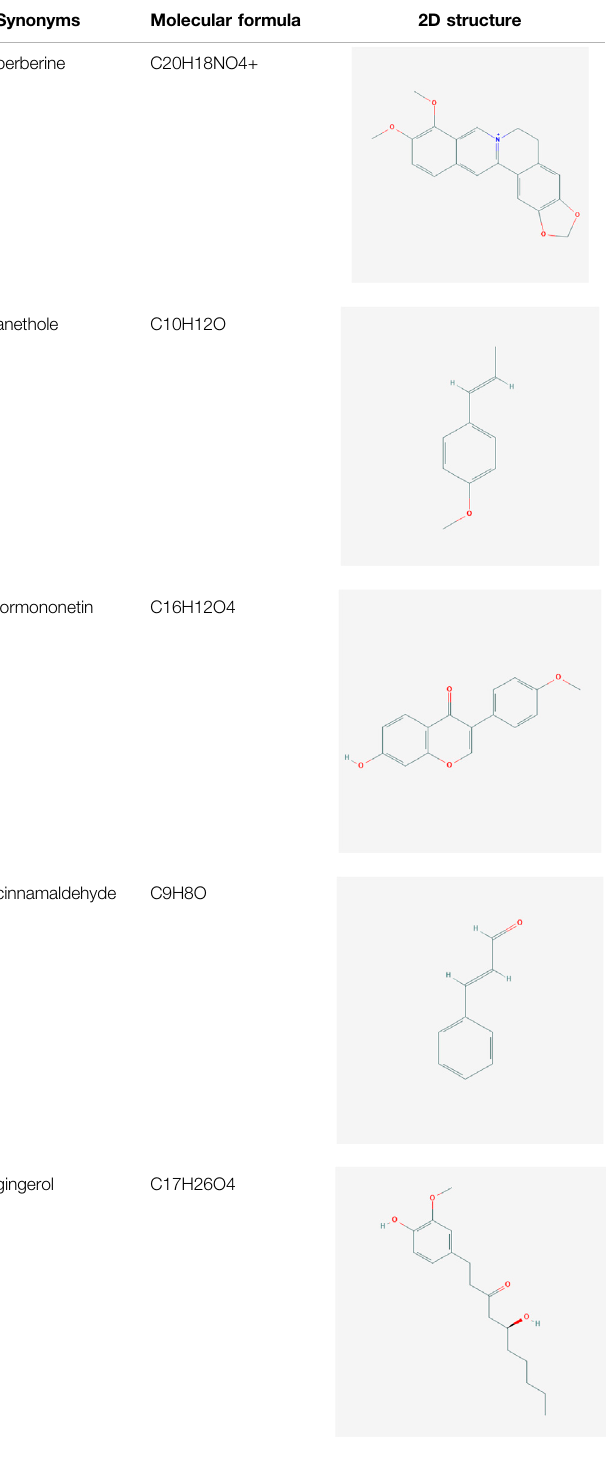
TABLE 3 | The chemical structure of Huangqi Jianzhong Tang bioactive compounds.